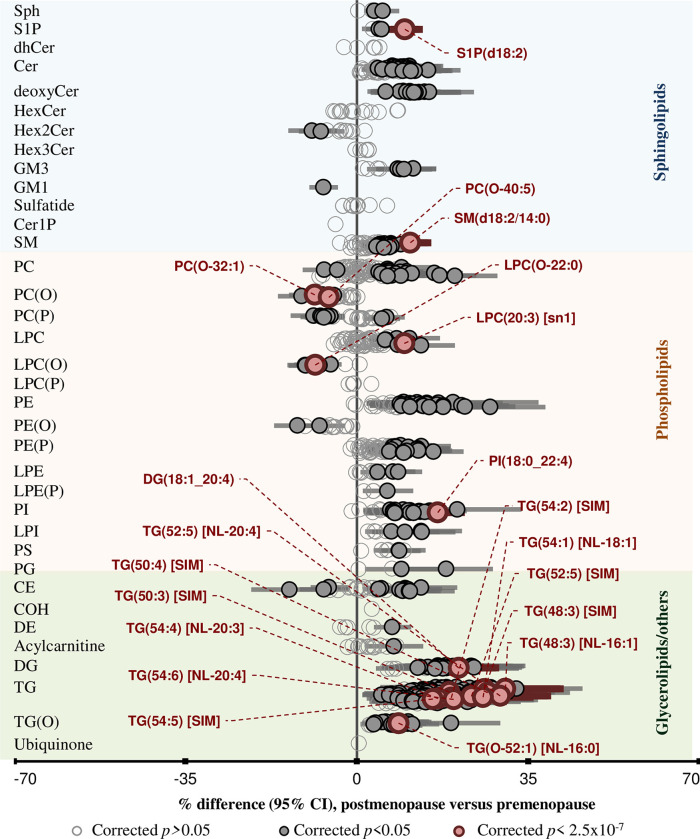
Association of lipid species with menopausal status.Multivariable linear regression analysis between menopausal status (post relative to pre) and log10-transformed lipid species concentrations was performed in women only, adjusting for age, BMI, smoking status, and diabetes status. Beta coefficients were converted to percentage difference of lipid level in postmenopausal relative to premenopausal women. Open circles show nonsignificant species (p > 0.05). Grey and pink closed circles show species with corrected p < 0.05 and corrected p < 2.5 × 10−7, respectively. See S1 Data for the underlying data. BMI, body mass index; CE, cholesteryl ester; Cer, ceramide; Cer-1-P, ceramide-1-phosphate; COH, free cholesterol; DE, dehydrocholesterol; deoxyCer, deoxyceramide; DG, diacylglycerol; dhCer, dihydroceramide; GM1, GM1 ganglioside; GM3, GM3 ganglioside; HexCer, monohexosylceramide; Hex2Cer, dihexosylceramide; Hex3Cer, trihexosylceramide; LPC, lysophosphatidylcholine; LPC(O), lysoalkylphosphatidylcholine; LPC(P), lysoalkenylphosphatidylcholine; LPE, lysophosphatidylethanolamine; LPE(P), lysoalkenylphosphatidylethanolamine; LPI, lysophosphatidylinositol; NL, neutral loss; PC, phosphatidylcholine; PC(O), alkylphosphatidycholine; PC(P), alkenylphosphatidylcholine; PE, phosphatidylethanolamine; PE(O), alkylphosphatidylethanolamine; PE(P), alkenylphosphatidylethanolamine; PG, phosphatidylgylcerol; PI, phosphatidylinositol; PS, phosphatidylserine; SIM, single ion monitoring; SM, sphingomyelin; sn, stereospecifically numbered; Sph, sphingosine; S-1-P, sphingosine-1-phosphate; TG, triacylglycerol; TG(O), alkyl-diacylglycerol.